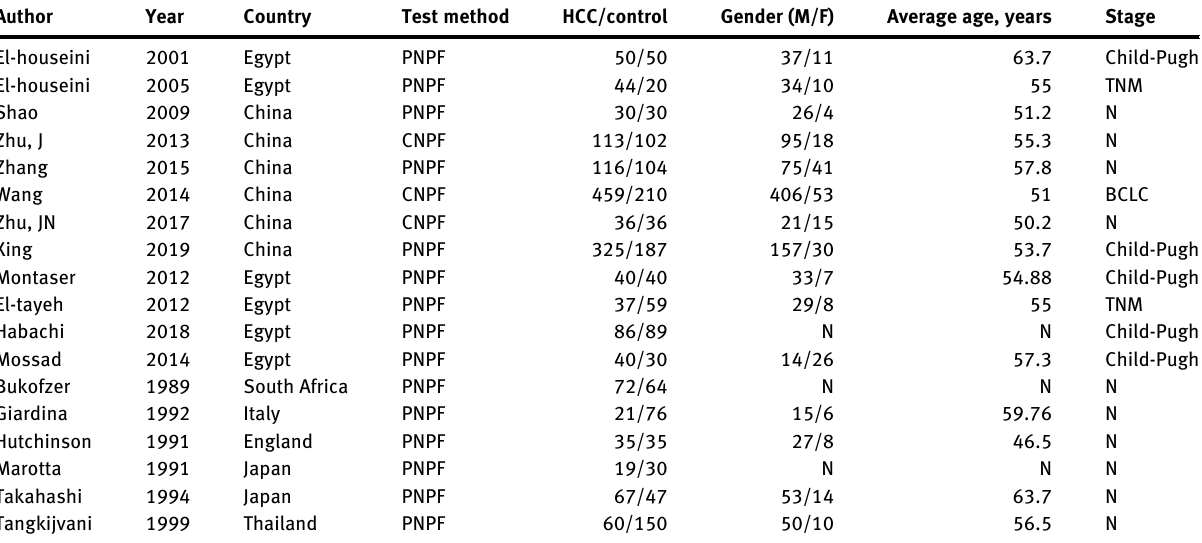
Table  : Main features of the articles selected.